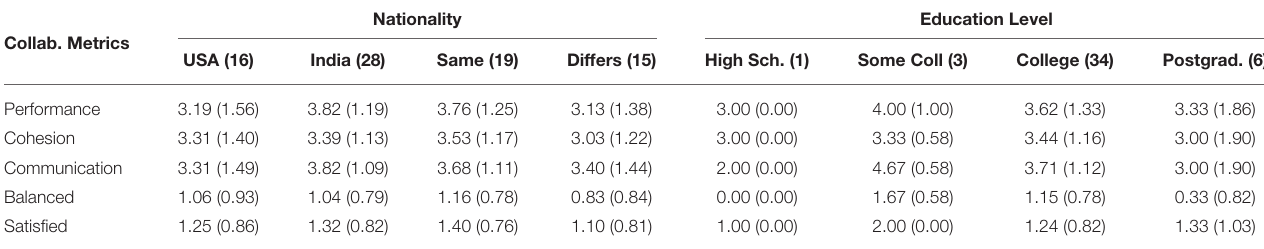
TABLE 11 | Mean (standard deviation) of collaboration quality metrics by nationality and education level, and also for teams that include the same or different nationalities.